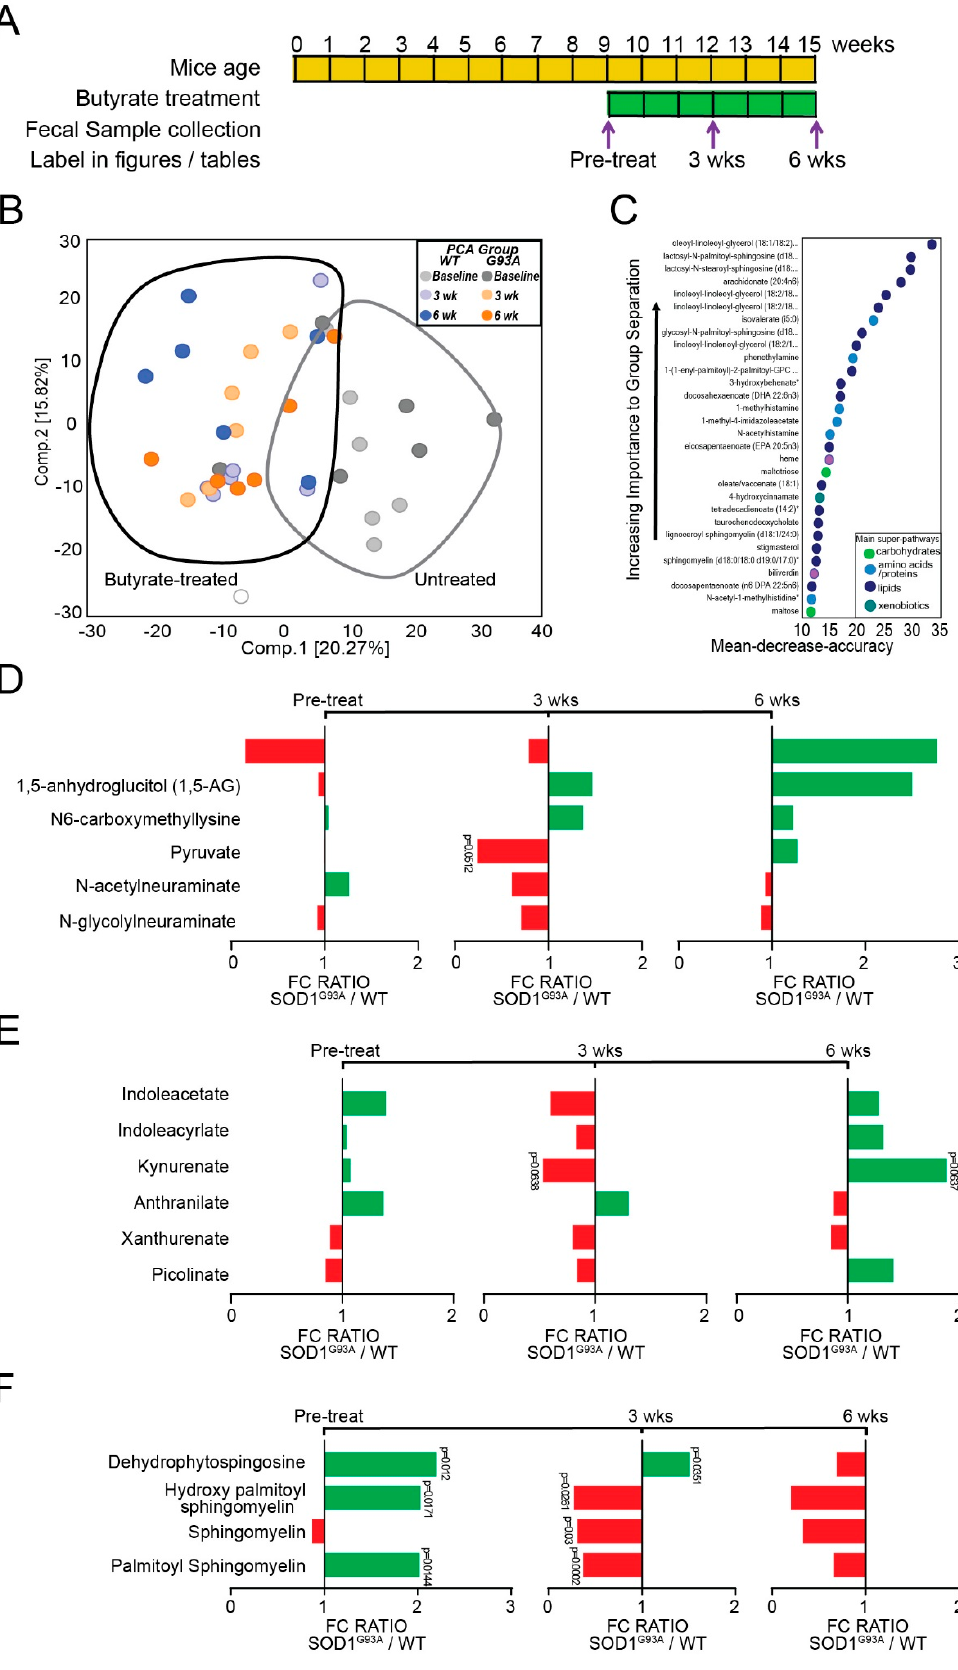
Figure 2. Effect of butyrate treatment on metabolite profile in ALS mice over the course of disease. ( A ) Schematic overview of the WT/SOD1 G93A mice treated with butyrate. Male or female SOD1 G93A